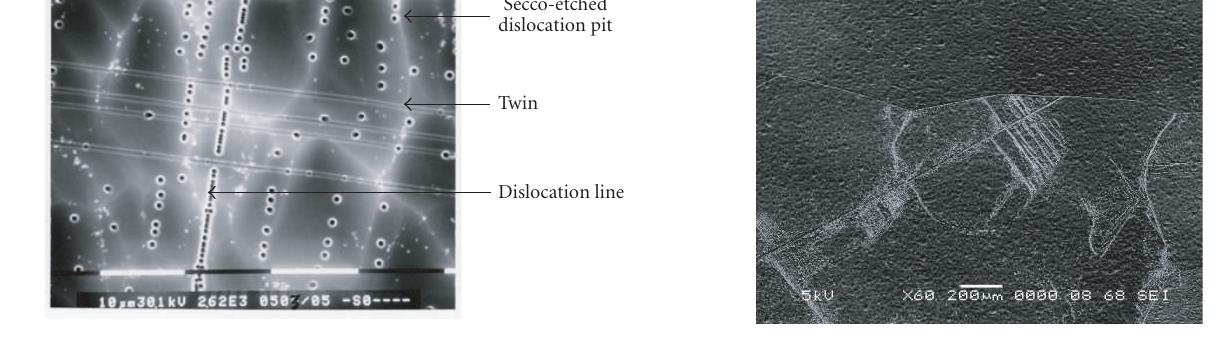
Figure 3: Defect-free surface nearby zones with high dislocation densities.